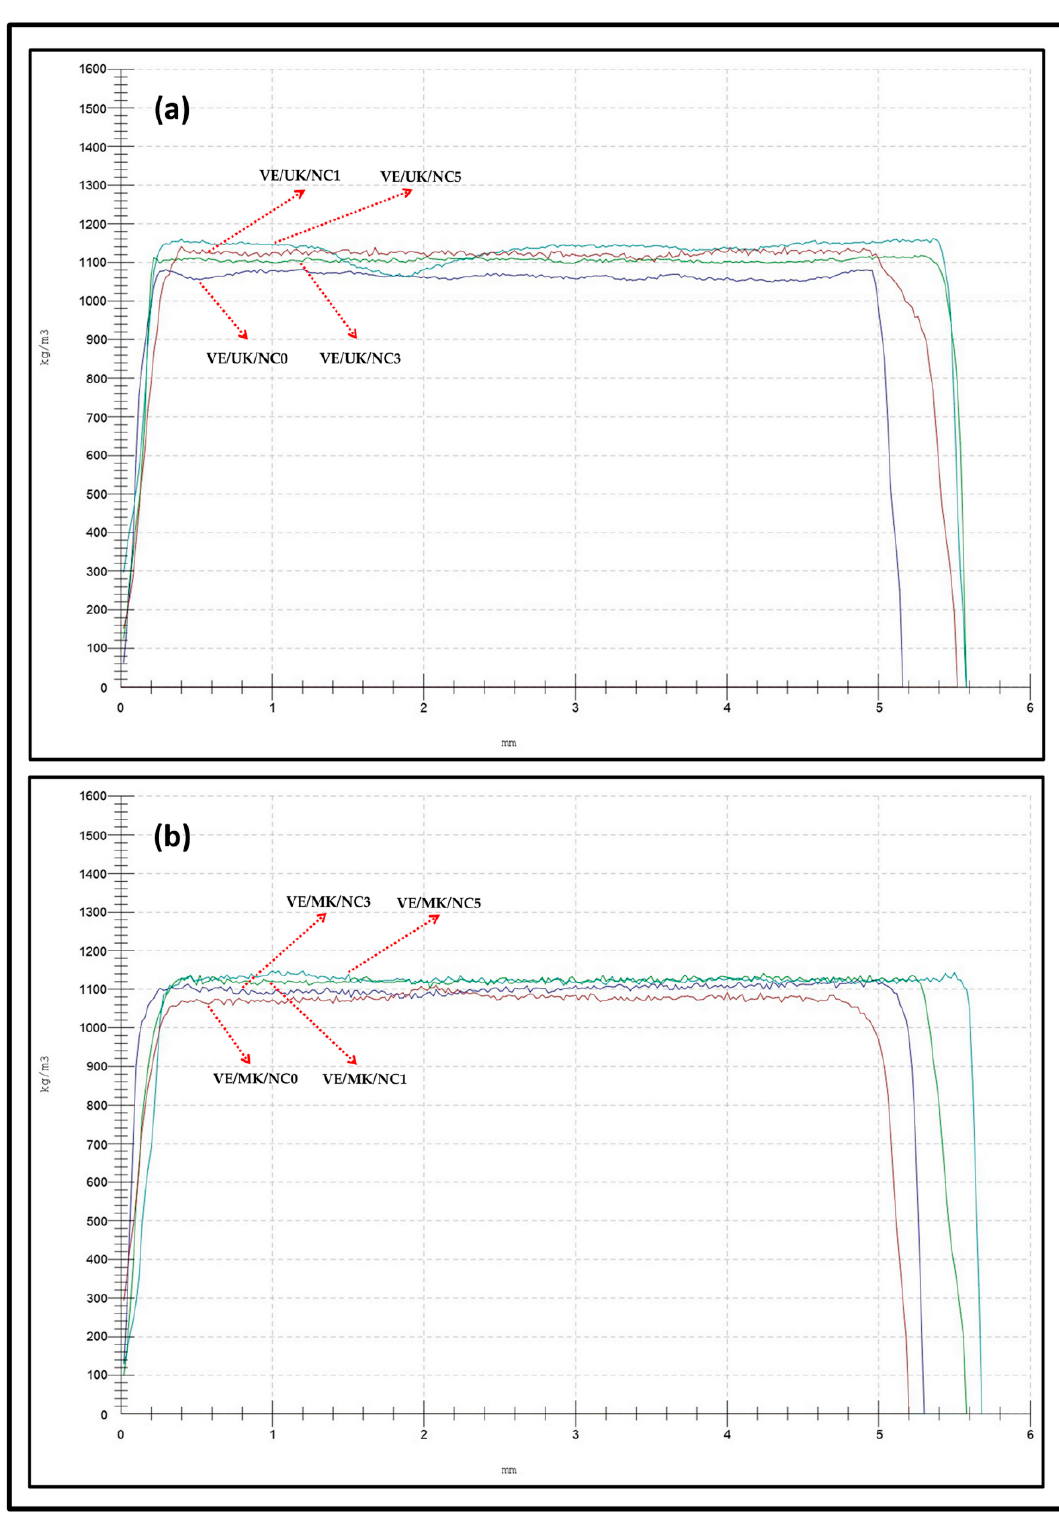
Figure 6. Density profile analysis of ( a ) unmodified and ( b ) modified kenaf reinforced